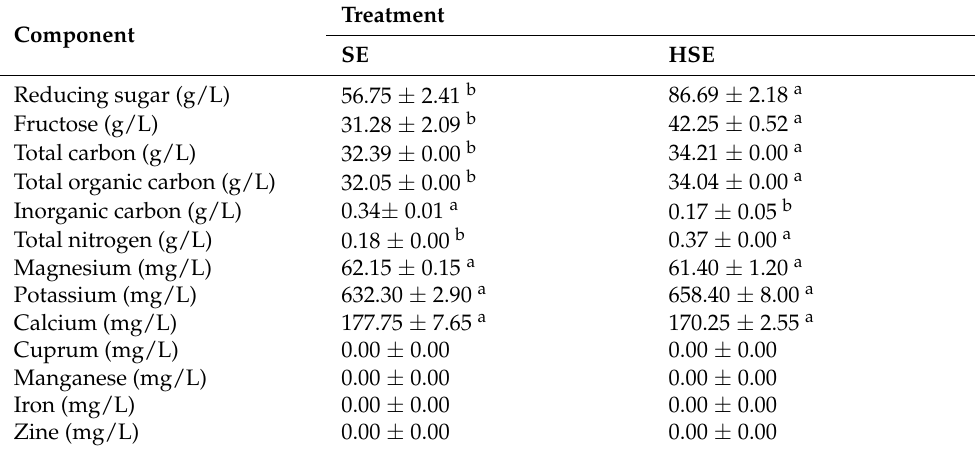
Table 2. Components of SE and